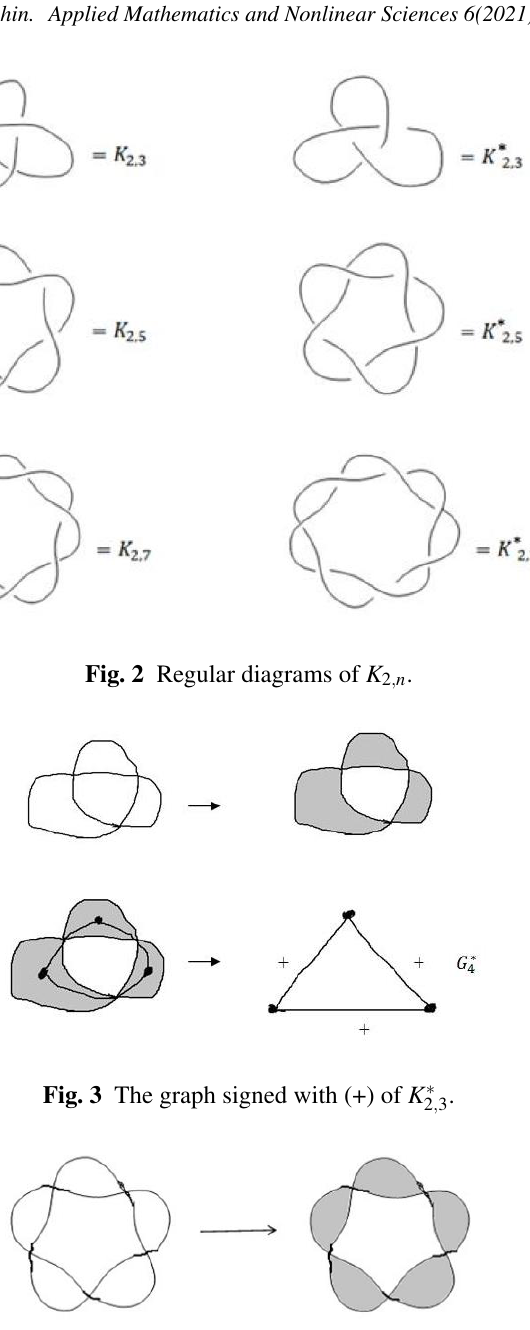
Fig. 4 The graph signed with (+) of K ∗